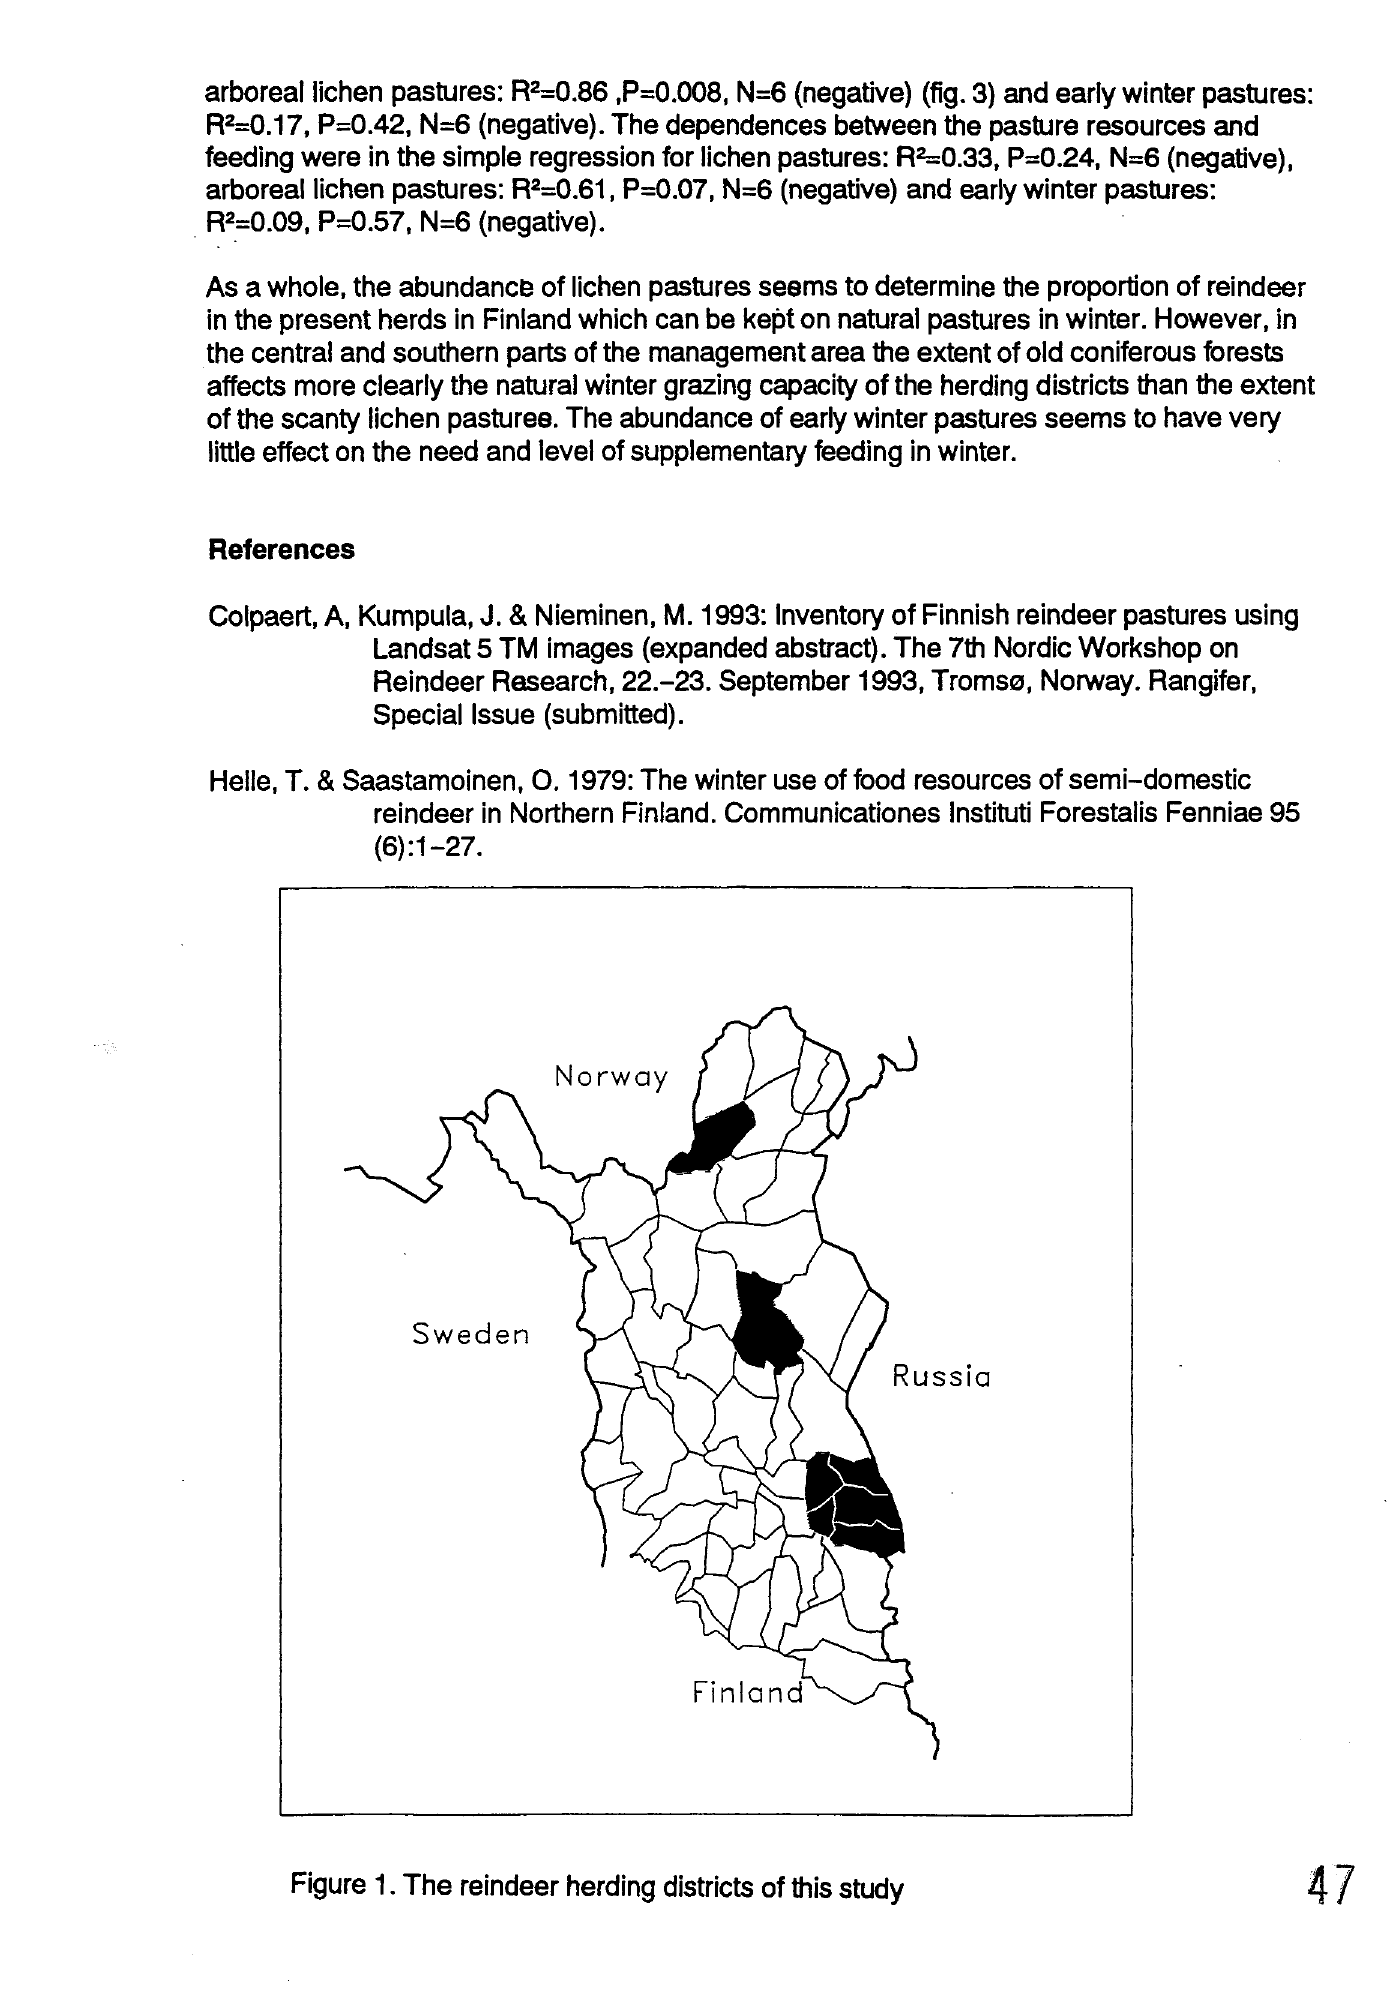
Figure 1. The reindeer herding districts of this